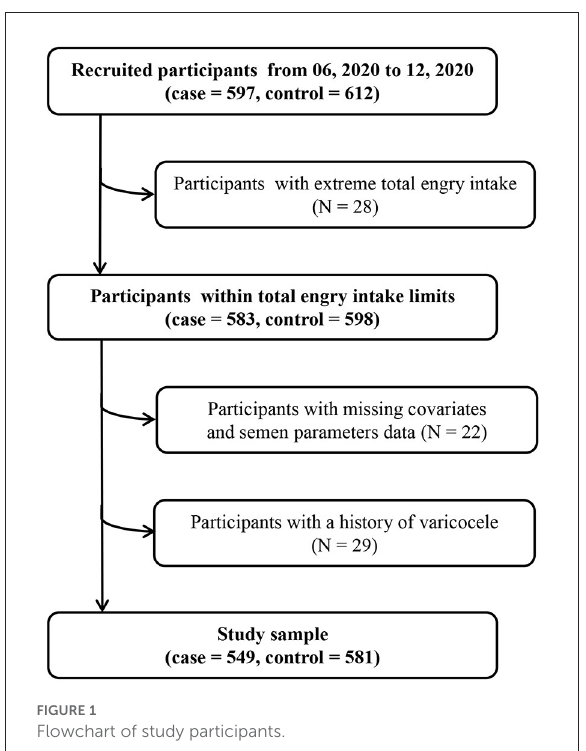
FIGURE1 Flowchart of study